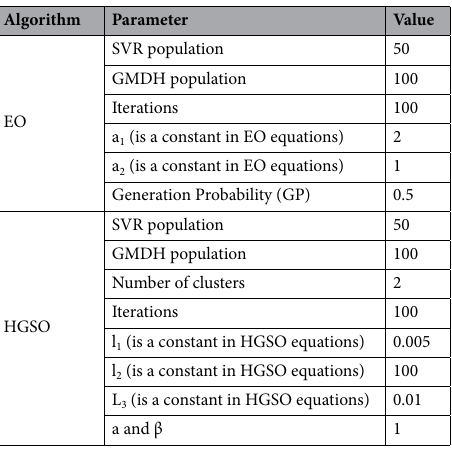
Table 2. Considered initial values of developed EO and HGSO algorithms for this study.